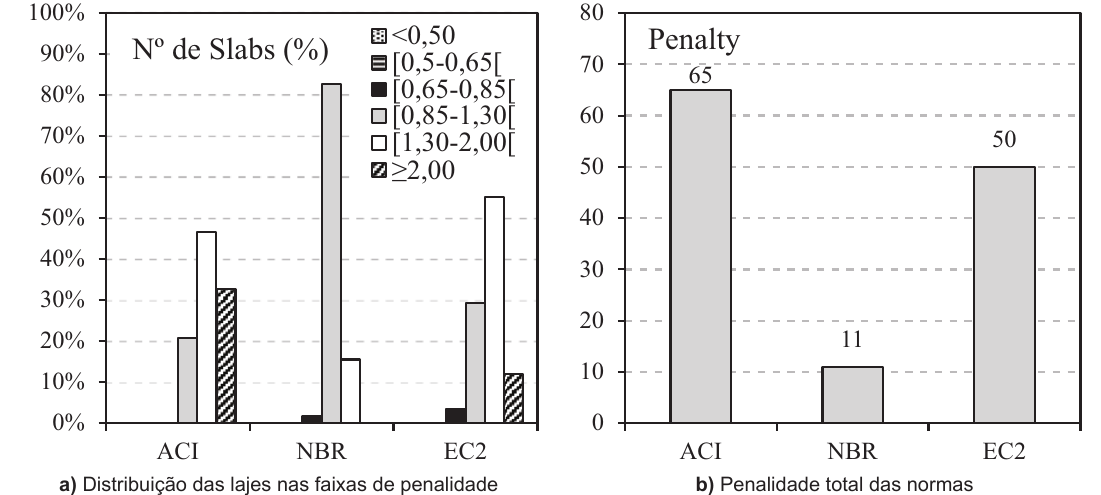
a) Distribuição das lajes nas faixas de penalidade b) Penalidade total das Desempenho das normas para lajes reforçadas à punção segundo o critério de Collins [23]